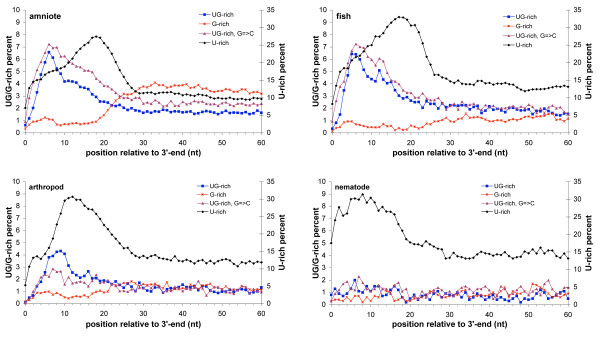
Tetramer positioning patterns for specific classes of organism. The plots from Figure 2 were grouped and averaged together according to the organism groupings listed as plot titles. In all plots, the U-rich element is plotted on the secondary vertical axis to allow greater detail to be observed in the other elements.